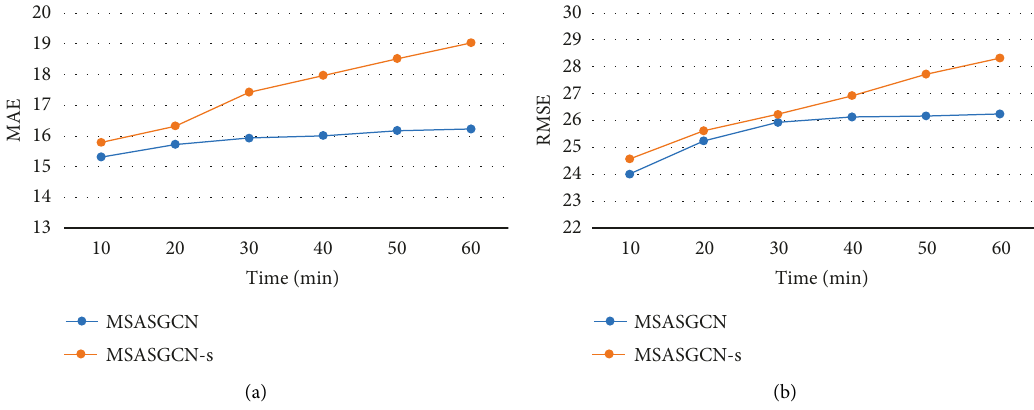
Figure 9: Module validation on the dataset PeMSD8. (a) The evolution of MAE. (b) The evolution of